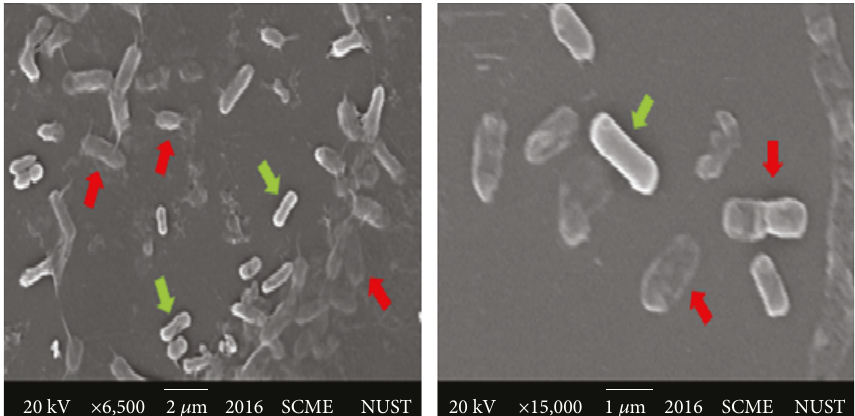
Figure 11: SEM micrographs of the M3 membrane with 0.5wt. % GO concentration following shake fl ask method to speci fi cally highlight S. typhi bacterial